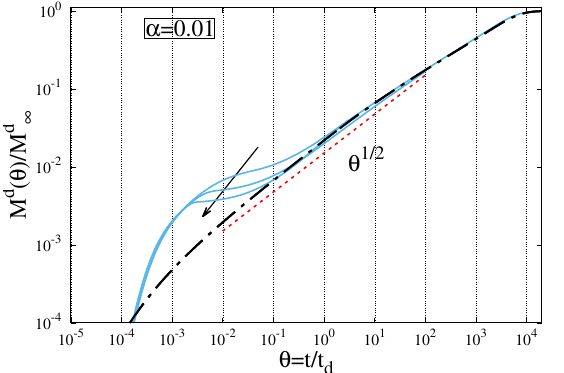
Figure 7. Drug release curves M d ( θ ) / M d ∞ for De = 10 − 2 , α = D d / D = 0.01, γ d = γ r /2 and γ r = 0,log10,log100. The arrow indicates increasing values of γ r . The dot-dashed black line represents the limiting case De →